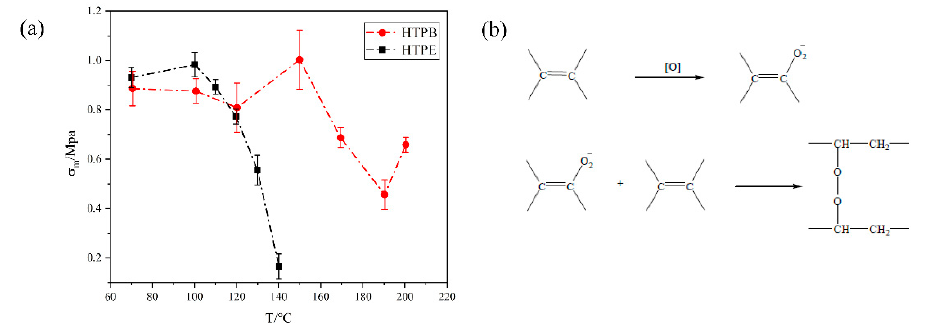
Figure 16. ( a ) The relationship between maximum tensile strength and temperature in HTPB and HTPE propellant ( b ) oxidation of C=C in HTPB.